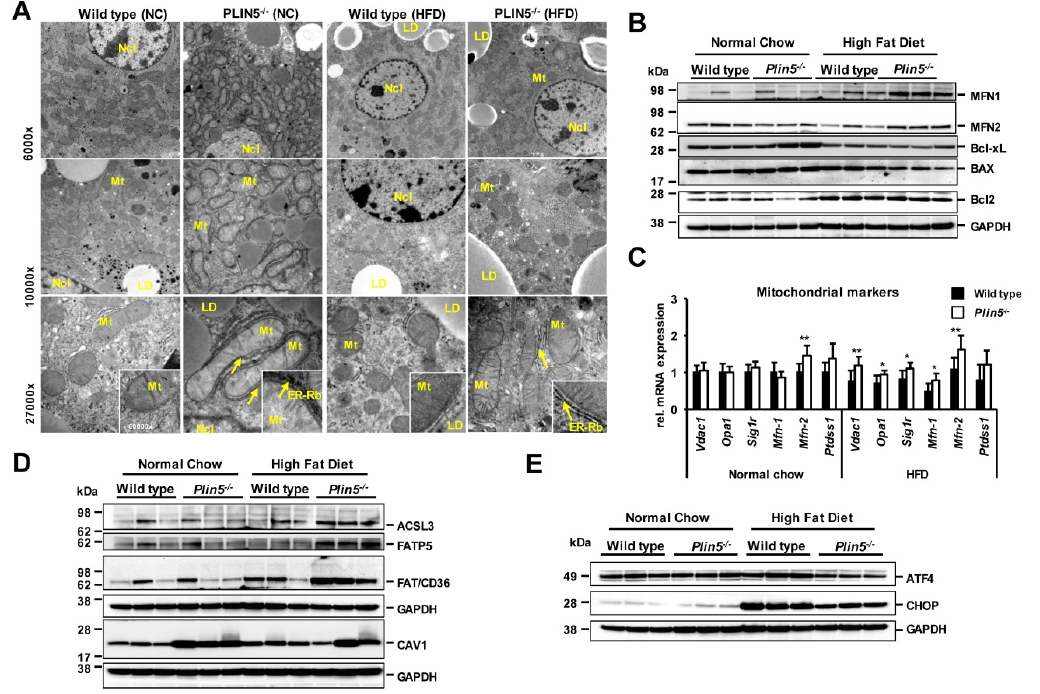
Figure 4. Plin5 a ff ects mitochondrial homeostasis. ( A ) Representative parenchymal liver pieces from wild type (WT) and Plin5 − / − animals fed a normal (NC) and high-fat diet (HFD) ( n = 3 / group) were observed after fixation with electron microscopy for hepatic mitochondria. Magnifications used were the 6,000 × , 10,000 × , 27,000 × and 60,000 × , respectively. The 60,000 × magnification is given in a smaller square part of the 27,000 × magnification images. Representative mitochondria (Mt), lipid droplets (LD) and nuclei (Ncl) are labeled and yellow arrows indicate the endoplasmic reticulum-ribosome presence (ER-Rb). ( B ) Western blot analysis of mitochondrial and apoptotic markers. ( C ) mRNA levels of mitochondrial markers involved in structure and function were tested in all experimental groups ( n = 4–7 animals/group). Data are expressed as mean ± SD. Statistical analysis was performed with Student’s t -test. * p < 0.05; ** p < 0.01. ( D , E ) Western blot analysis of proteins related to fatty acid